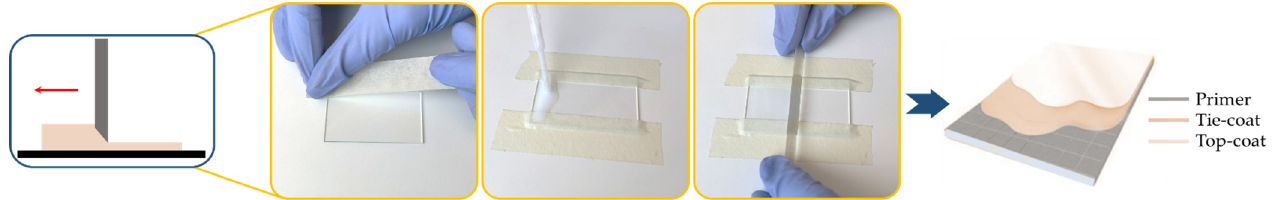
Figure 5. Doctor blade method for functional coating deposition.